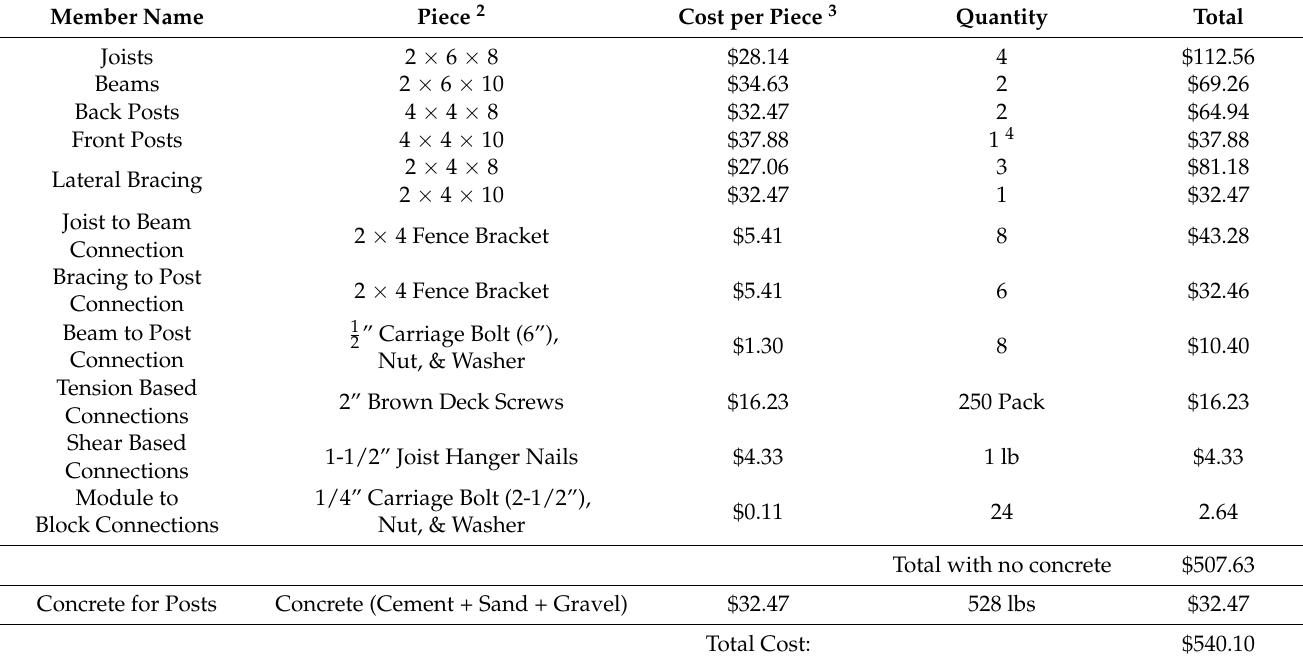
Table 6. 10 Degree Fixed Rack List of Materials for Lom é Togo if purchased in Togo 1 .